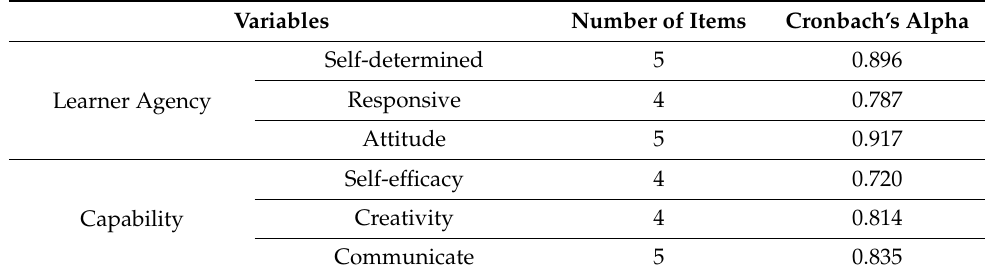
Table 2. Reliability of the Test